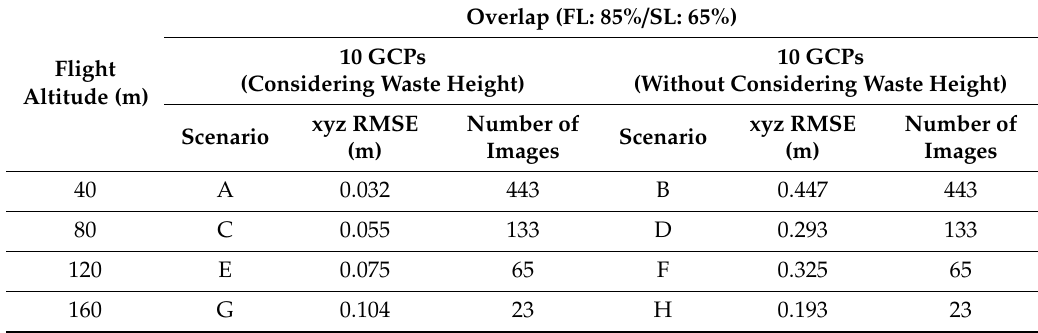
Table 1. Unmanned aerial vehicle (UAV)-based point cloud accuracy for various UAV flight scenarios. Overlap (FL: 85% / SL: 65%) 10 GCPs 10 GCPs Flight (Considering Waste Height) (Without Considering Waste Height) Altitude (m) Number of Number of Scenario Scenario (m) Images (m)